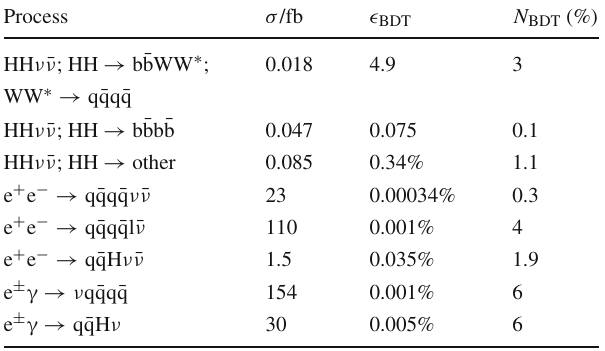
Table 1 Cross sections, σ , selection efficiencies, (cid:14) BDT , and expected number of events in the HH → b ¯ bWW ∗ signal region, N BDT , at √ s = 1.4TeV for L = 2 . 5ab − 1 . The cross sections are for unpolarised